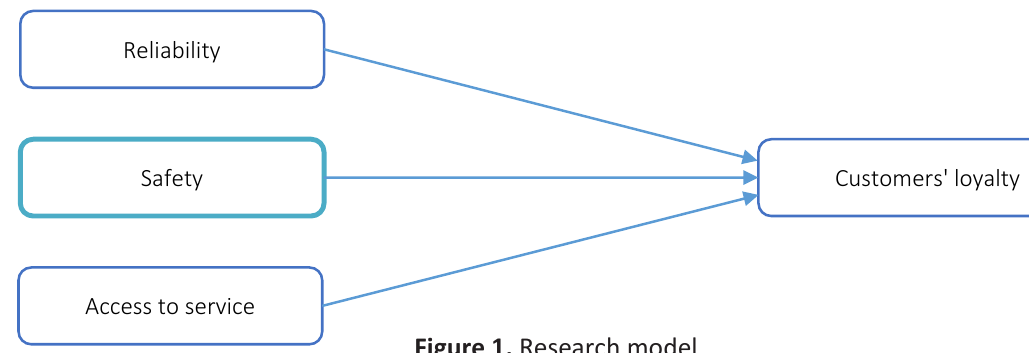
Figure 1. Research model